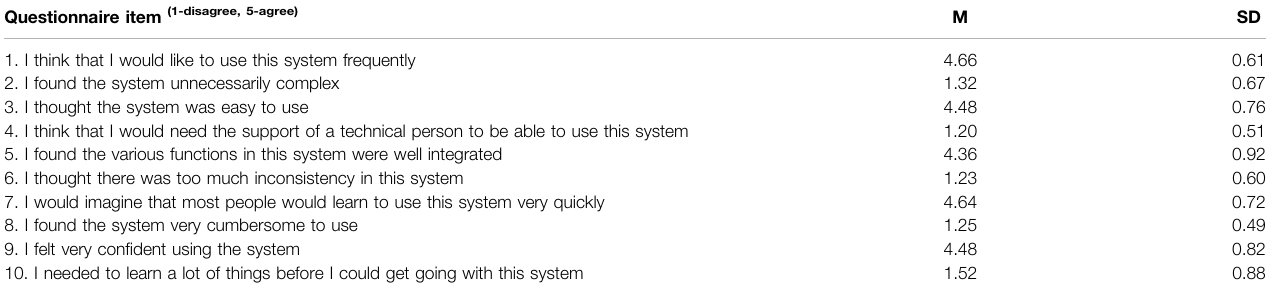
TABLE 1 | The results for each item of the SUS questionnaire. Questionnaire item (1-disagree, 5-agree)